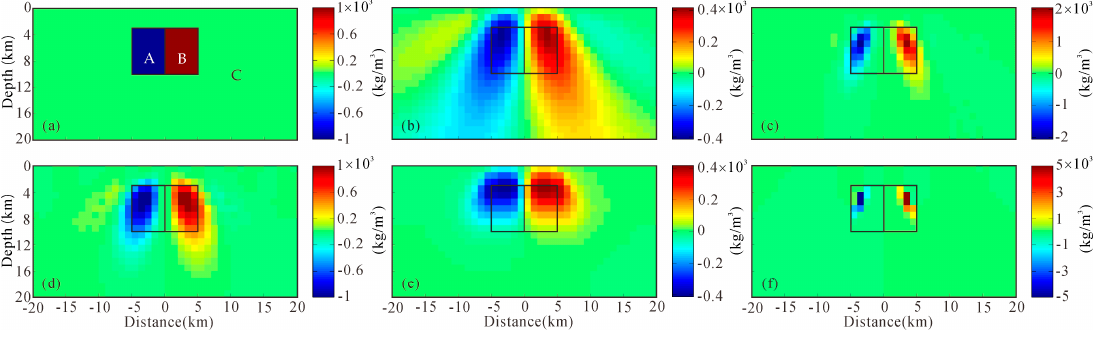
Figure 2. Gravity separate inversion results obtained using different regularization methods. ( a ) Density true model; ( b ) Density inversion model using L2 regularization; ( c ) Density inversion model using L1 regularization; ( d ) Density inversion model using elastic-net regularization; ( e ) Density inversion model using TV regularization; ( f ) Density inversion model using focusing regularization. The black box indicates the boundary of the anomalous body. Table 1. The resistivities and residual densities of synthetic model